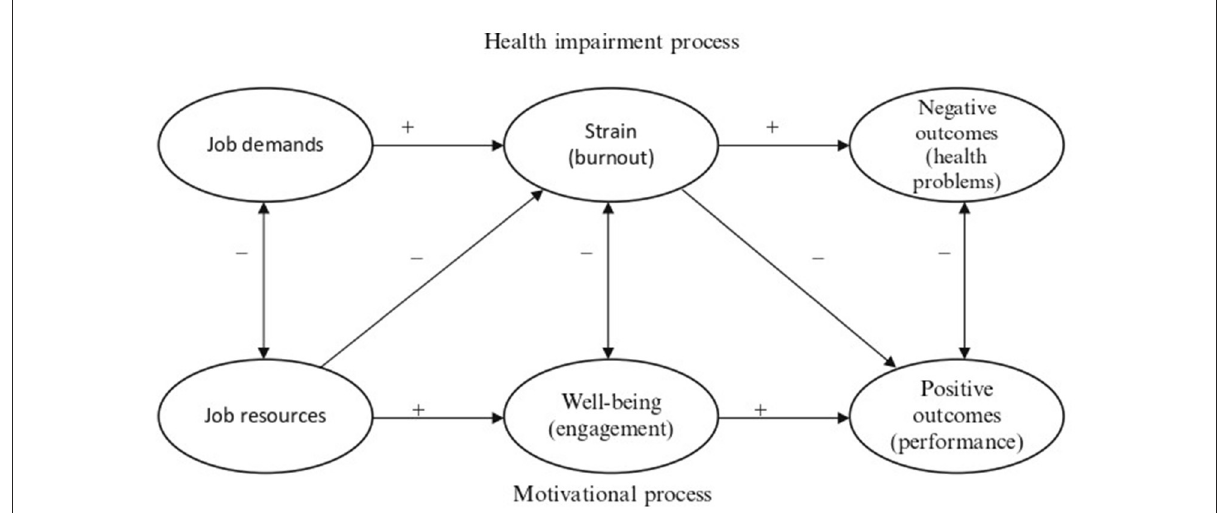
FIGURE2 The health-impairment and motivational role of JD-R theory, adapted by Schaufeli and Taris